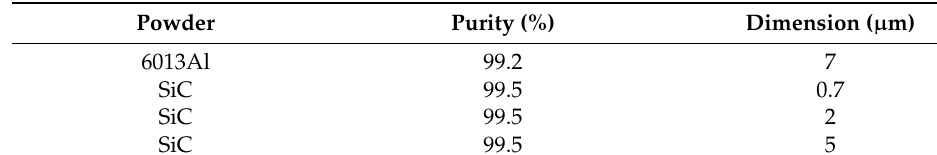
Table 1. The purity rate and dimensions of powders.